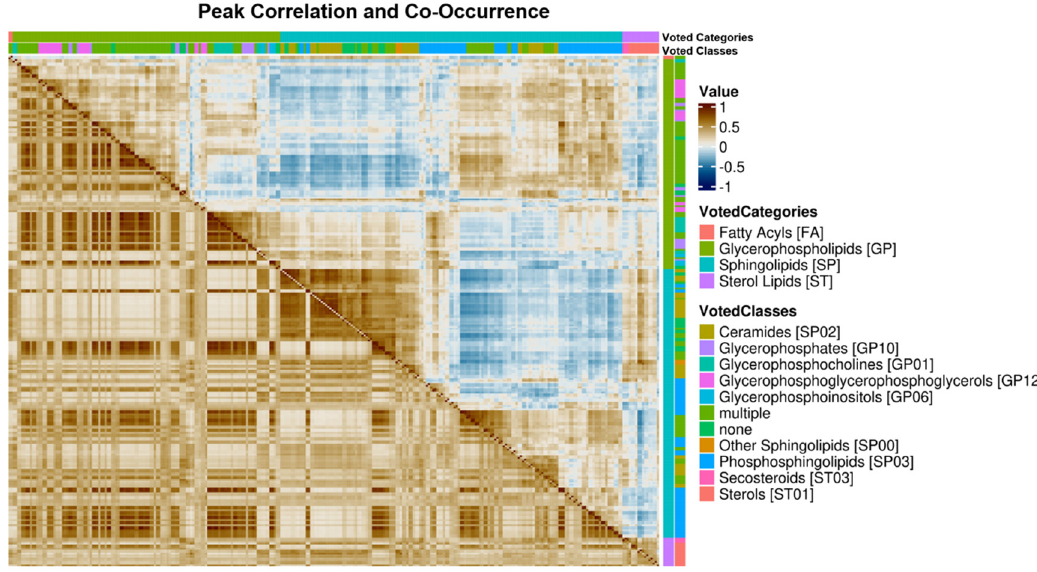
Figure 4. Peak correlation and peak co-occurrence combined heatmap. The upper-right corner shows the Kendall-tau correlation among consistently assigned lipid features. Strong intra-category correlation is observed for some lipids which possibly results from co-regulation. Shown in the bottom-left is the co-occurrence of consistently assigned lipid features. There are two sub-populations of sterols: one that co-occurs with a sub-population of sphingolipids and another that co-occurs with a sub-population of glycerophospholipids. The biological relevance of this co-occurrence is unclear. Alternatively, this co-occurrence may simply be artifactual, if these lipids were generally of lower relative abundance.